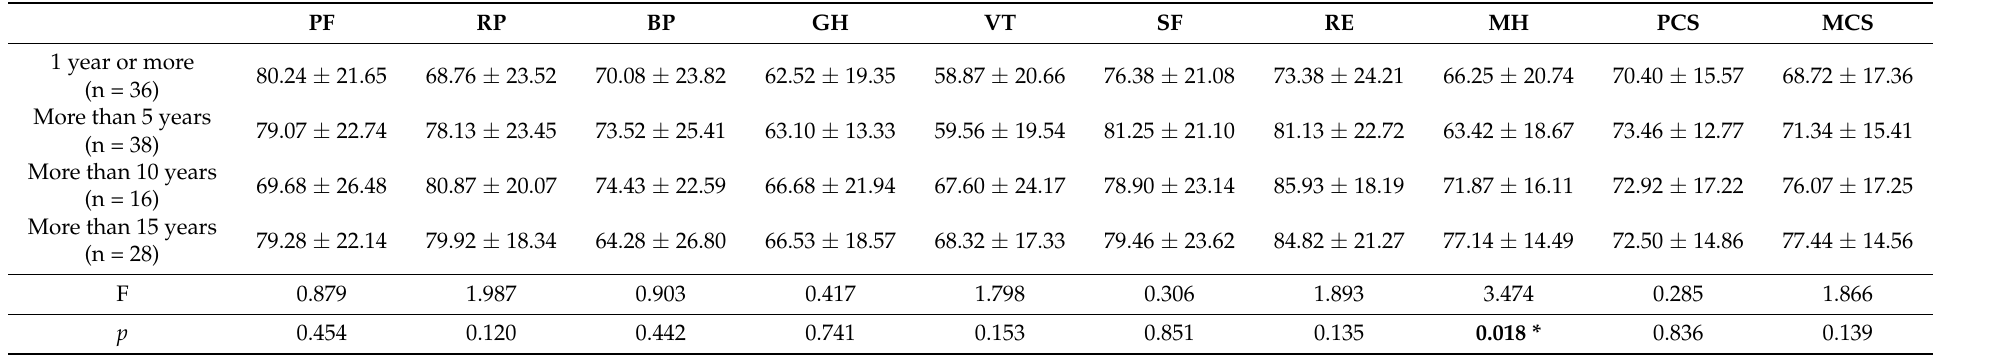
Table 2. Degree of HRQOL depending on exercise